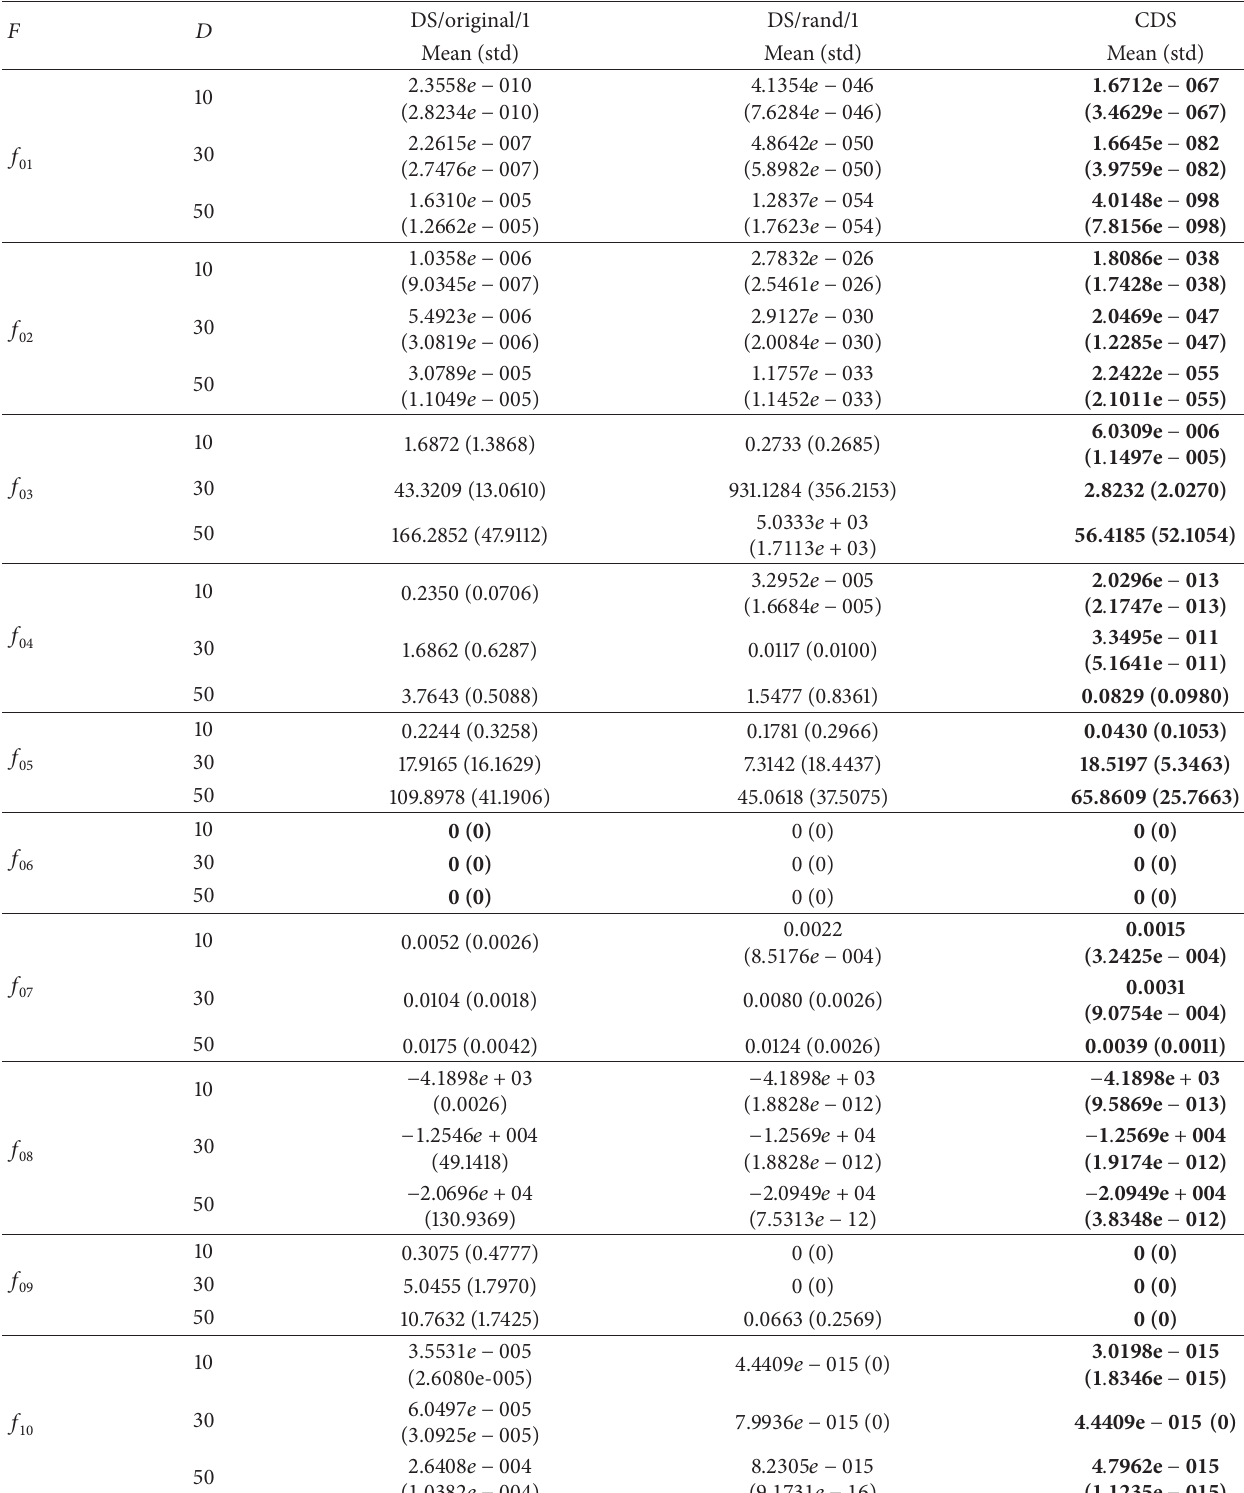
Table 8: Comparisons of CDS with DS/original/1 and